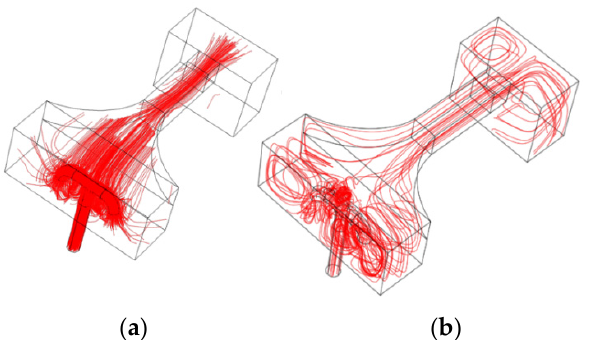
Figure 6. Three-dimensional streamlines obtained from an ( a ) Laminar model and ( b ) Turbulent model. The Turbulent model captures well the twin circulation zone occurring in the drainage tank and the collecting chamber. The Laminar model fails to capture the circulation zone despite of the use of large number of elements.